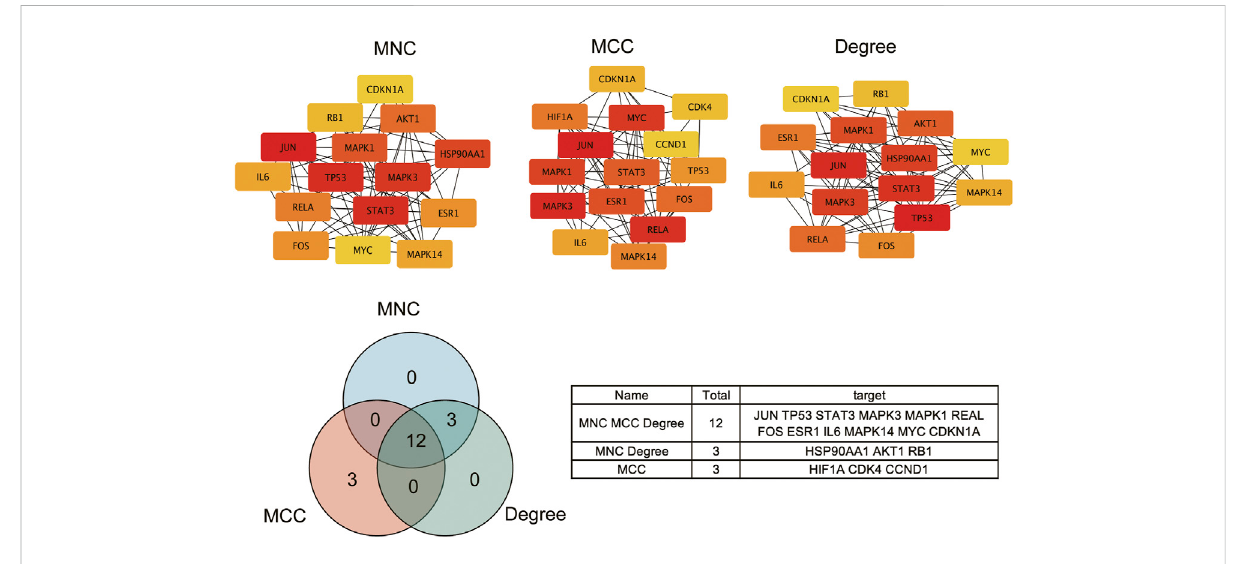
FIGURE 3 Screening intersective hub